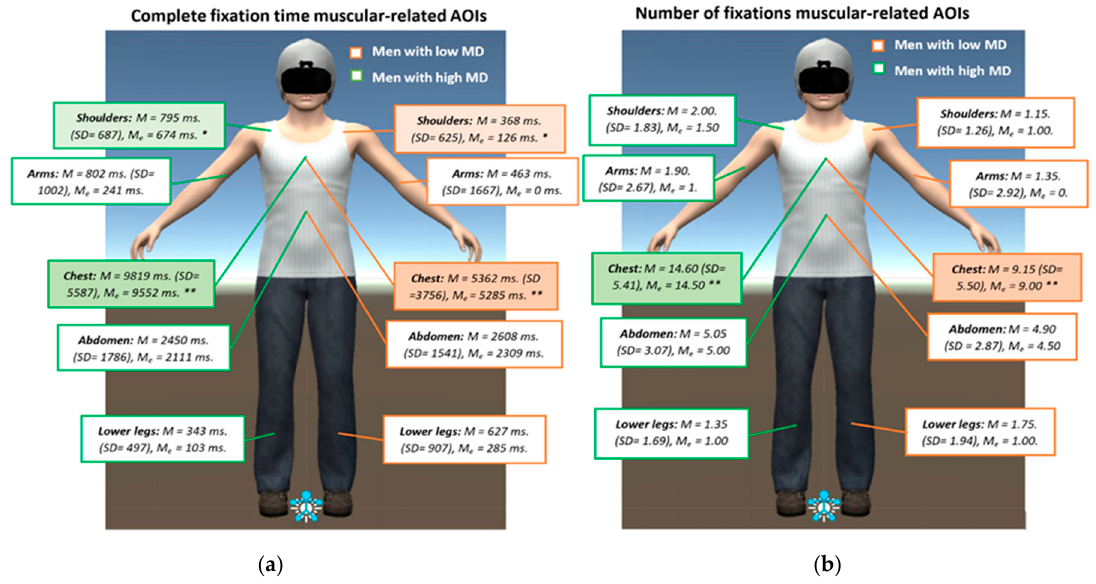
Figure 4. Differences between men with high and low muscularity dissatisfaction (MD) (in mean, standard deviation, and median) in complete fixation time (in milliseconds; ms) and number of fixations on individual muscle-related areas of interest (AOIs). Mann–Whitney U test analyses: * p = 0.04, ** p < 0.01. ( a ) Complete fixation time; ( b ) Number of fixations.